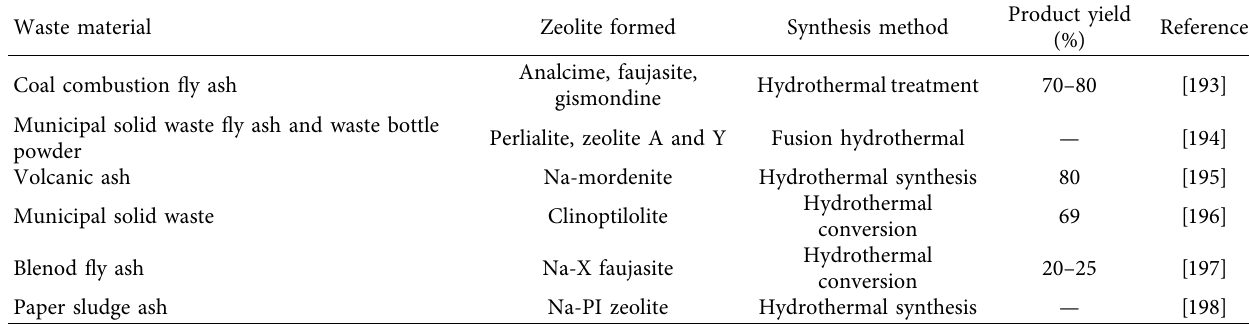
Table 3: Other wastes in the synthesis of zeolites.